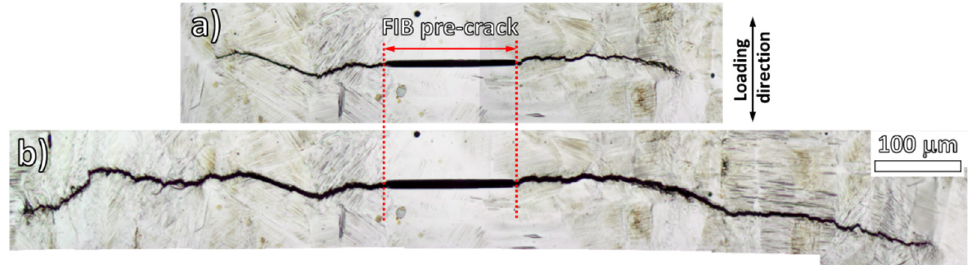
Figure 5. Crack growth at the surface of 304L cycled at ε a = 4 × 10 − 3 . Crack propagation is shown in two stages of cycling: ( a ) at N P1 = 12000 cycles and ( b ) at N P2 = 15100 cycles.